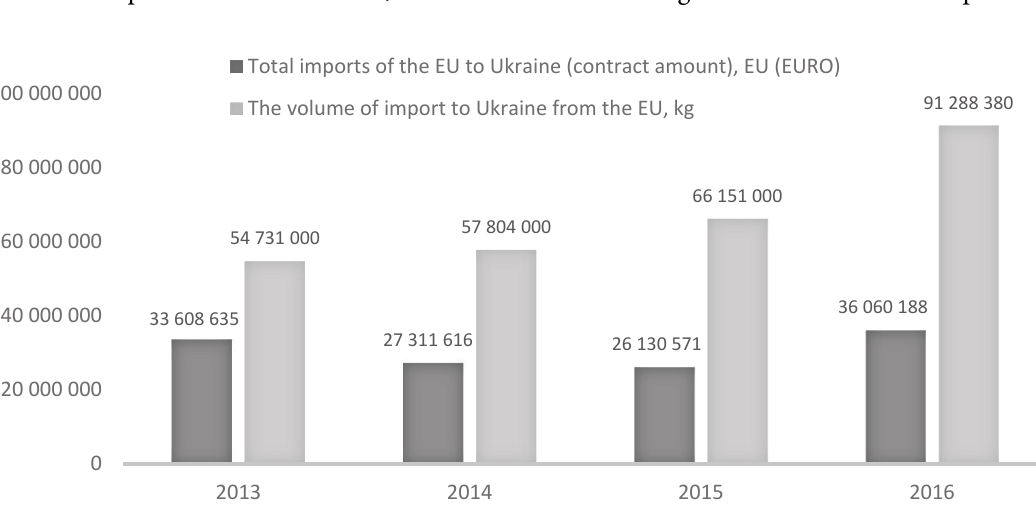
Figure 8. Analysis of chicken meat import from the EU in